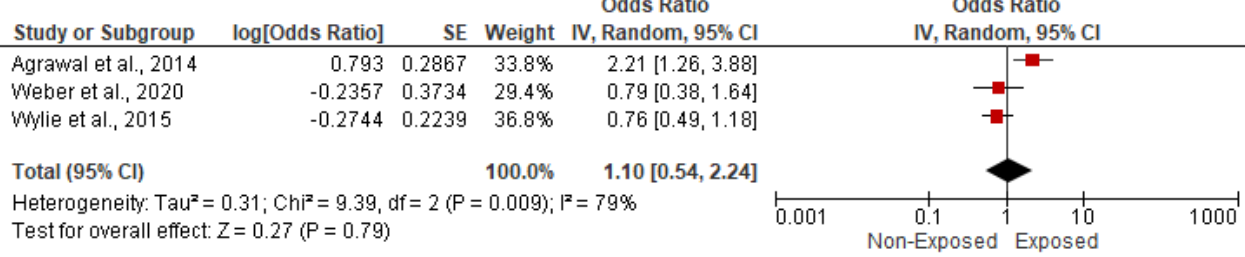
Figure 14. Forest plot of summary analysis of the Odds ratio and 95% CI of the association between HAP and eclampsia/pre-eclampsia. The size of the red squares is proportional to the statistical weight of each trial. The gray diamond represents the pooled point estimate. The positioning of both diamonds and squares (along with 95% CIs) beyond the vertical line (unit value) suggests a significant outcome (IV = inverse